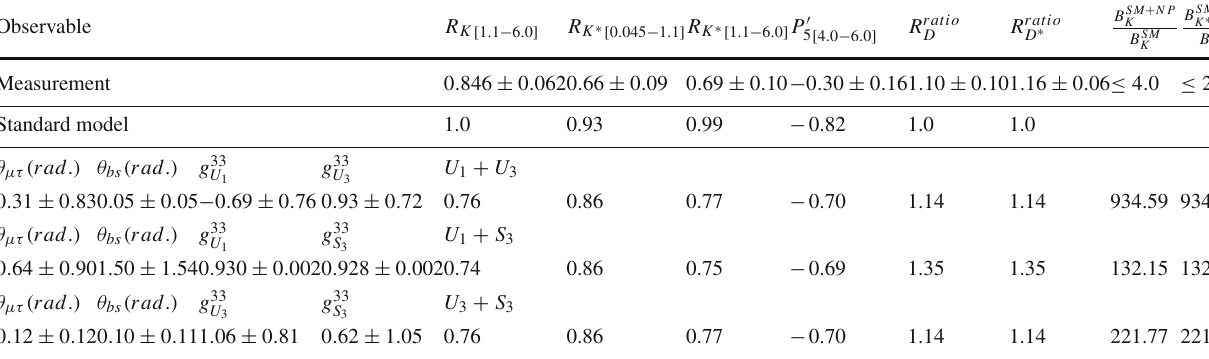
Table 5 Fit results for ( U 1 + U 3 ) , ( U 1 + S 3 ) and ( U 3 + S 3 ) combinations of two LQ particles